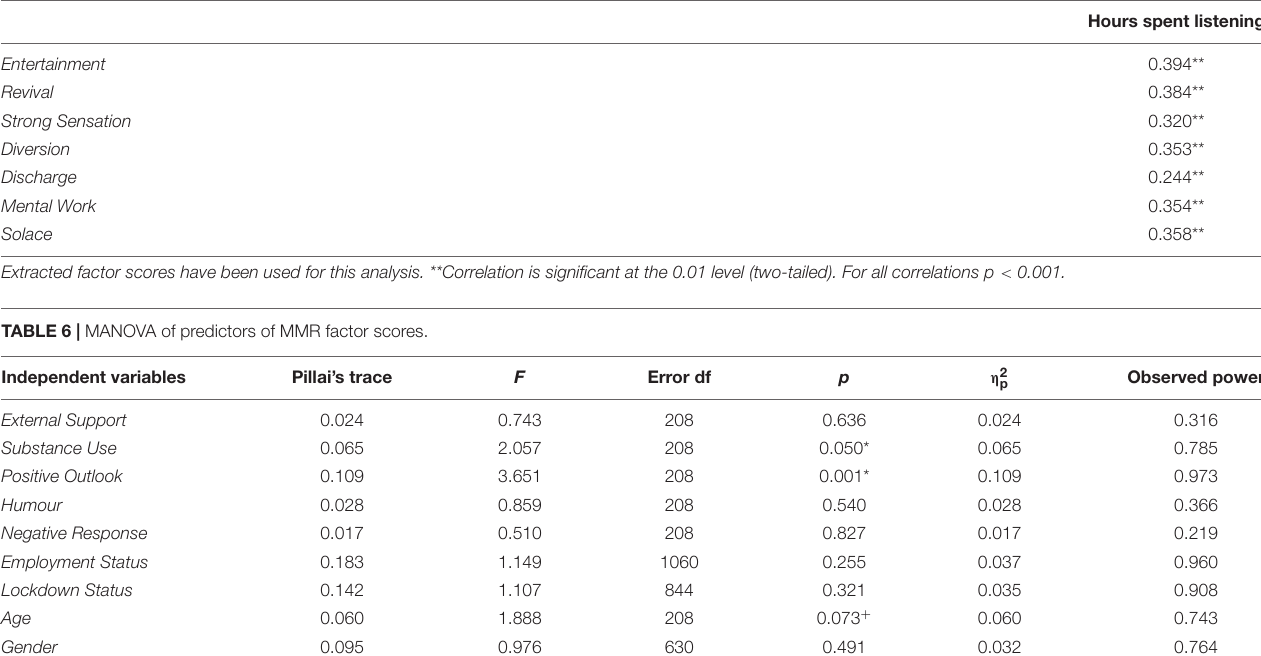
TABLE 5 | Bivariate correlation of hours spent listening and MMR subscales.